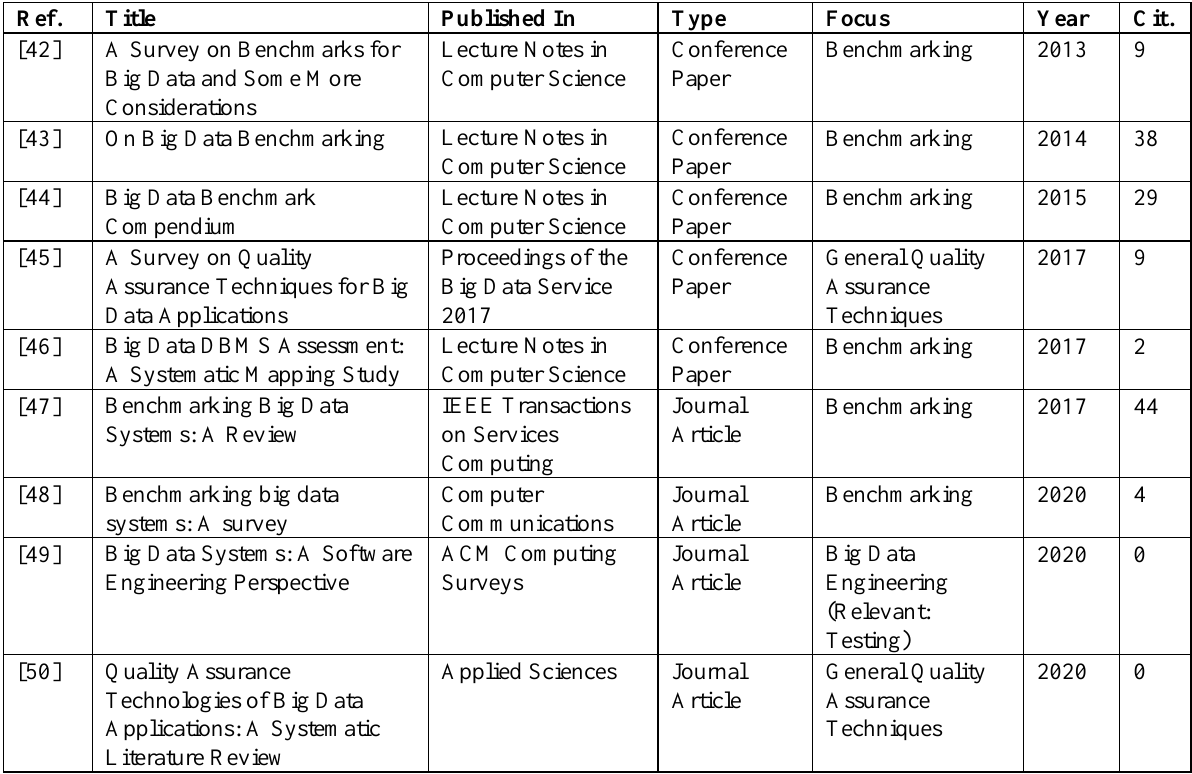
Table 4. Overview of the Regarded Review Papers